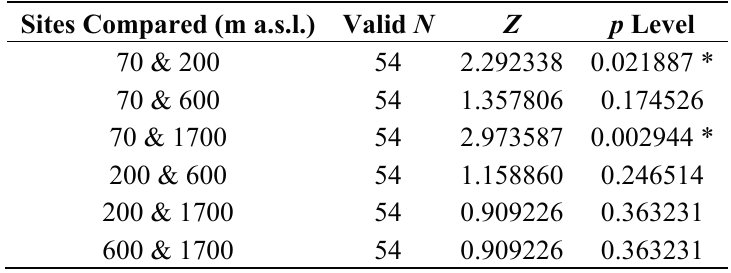
Table 4. Between-site comparison of allele frequency at